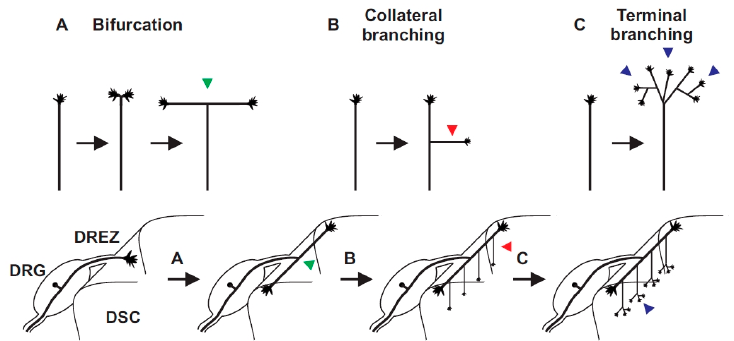
Figure 2. Three branching modes can be deduced from sensory axons in the spinal cord: ( A ) bifurcation (arrow head in green); ( B ) collateral formation from stem axons (arrow head in red); and ( C ) terminal branching in specific layers of the spinal cord (arrow head in blue). DREZ, dorsal root entry zone; DRG, dorsal root ganglia; DSC, dorsal spinal cord. It is of importance to note that all sensory axons show more or less the same pattern of branching.